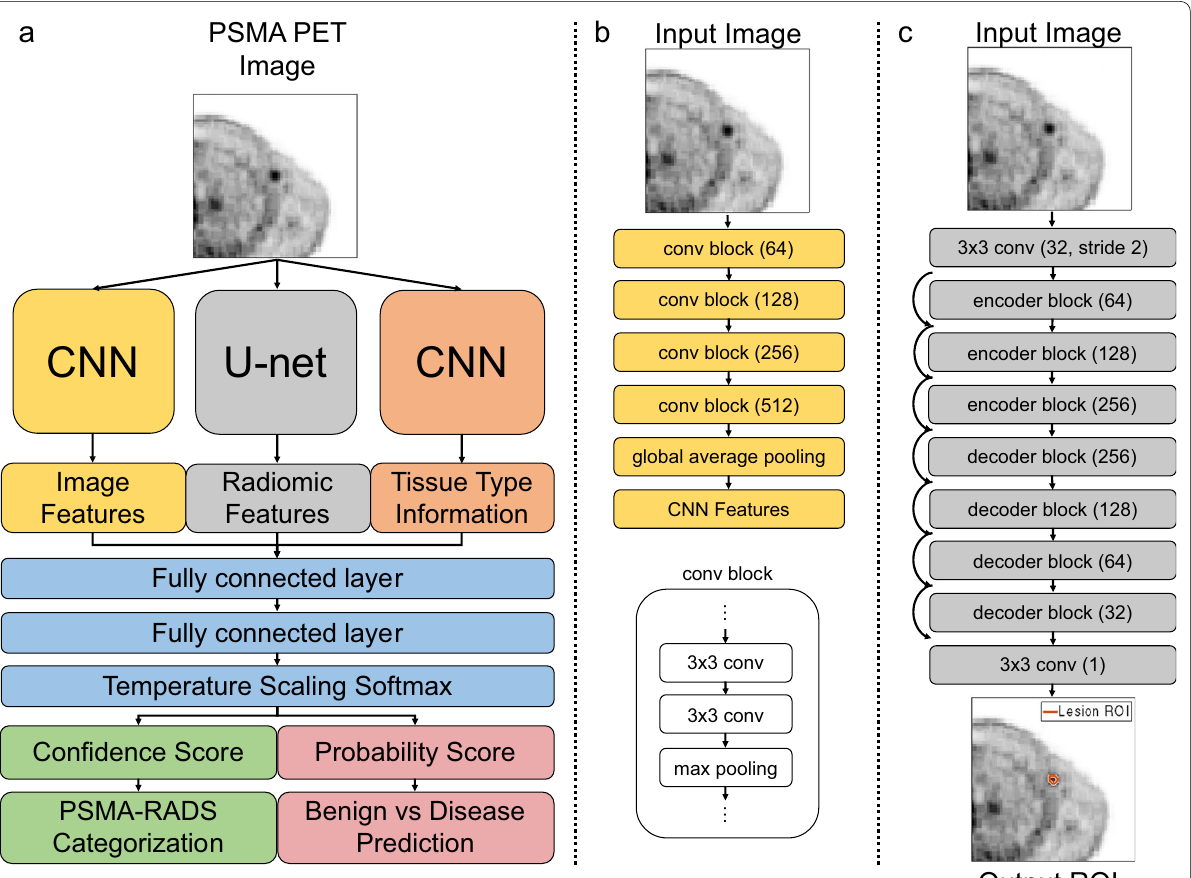
Fig. 2 Deep learning and radiomics framework ( a ). CNN architecture ( b ). U-net architecture where curved arrows represent residual connections ( c ). Values in parentheses refer to the feature map